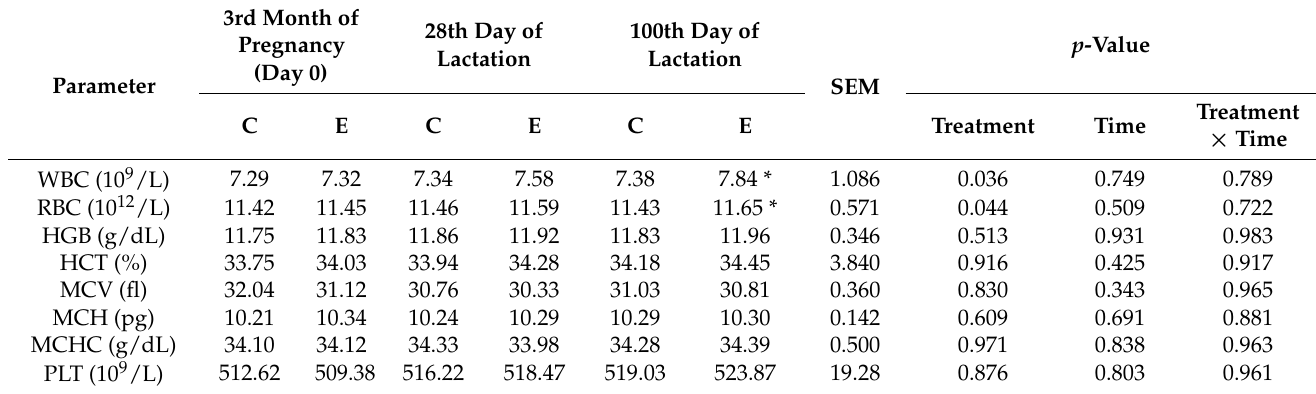
Table 3. Hematological parameters.